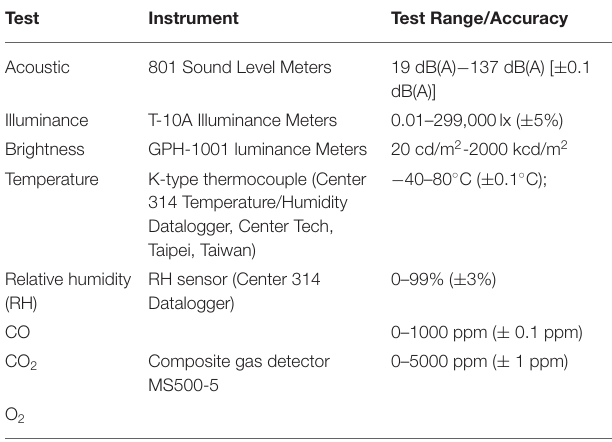
TABLE 2 | Measurements and instruments used in the